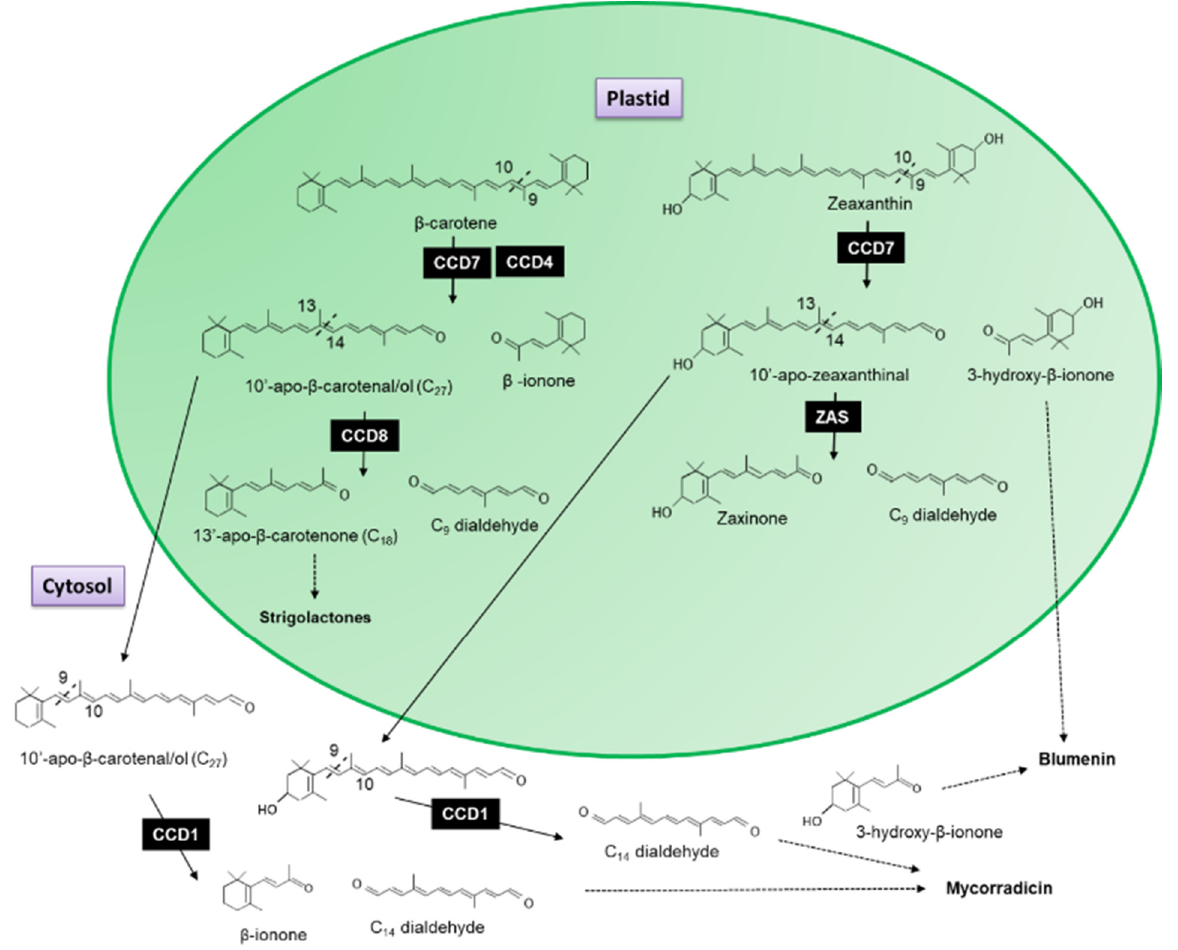
Figure 3. Scheme for the 9,10-cleavage of β -carotene and zeaxanthin catalysed by CCD7 and CCD4 into β -ionone and 10-apo- β -carotenal (C 27 compound) and 3-hydroxy- β -ionone and 10-apo- β -zeaxanthinal (C 27 compound). The 13,14 cleavage by CDD8 resulting in the formation of 9-apo- β -caroten-9-one (C 9 dialdehyde) and the 13-apo- β -carotenone, the precursor of strigolactones. The 13,14 cleavage of 10-apo- β -zeaxanthinal by Zaxinone Synthase (ZAS) forms Zaxinone and the C 9 dialdehyde. The C 27 compound is cleaved by CCD1 in the cytosol into β -ionone, 3-hydroxy- β -ionone and rosafluene-dialdehyde (C 14 dialdehyde—see Figure 4), the precursor for